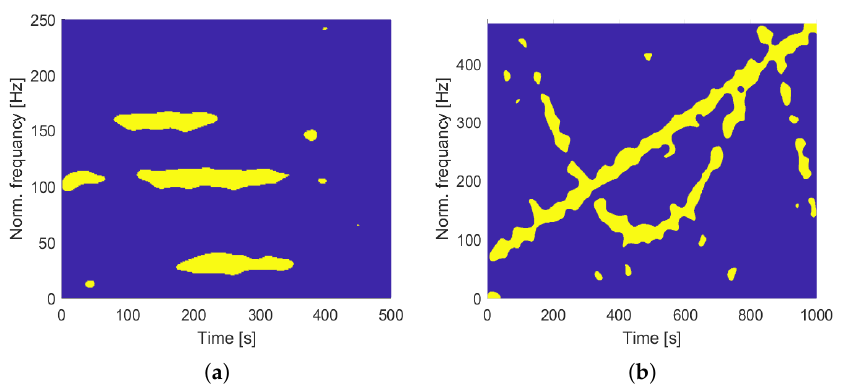
Figure 11. Extracted useful information content obtained by applying the 2DLEM method with the Shannon entropy for SNR = 0 dB. ( a ) Classification mask for the first signal. ( b ) Classification mask for the second signal.